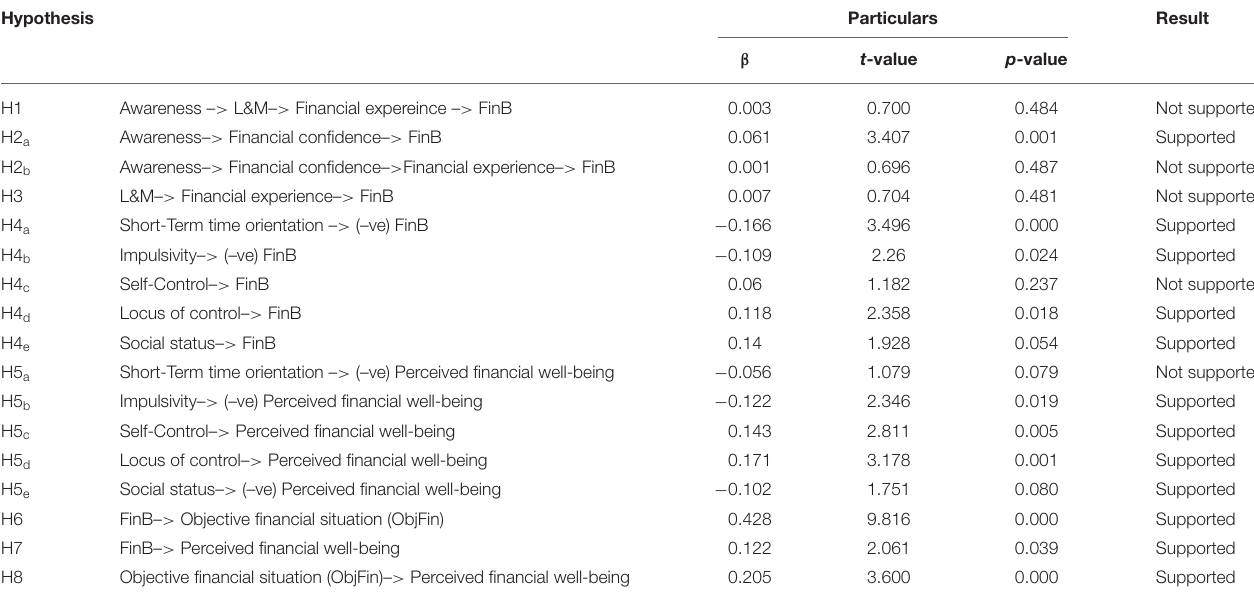
TABLE 9 | Hypothesis testing